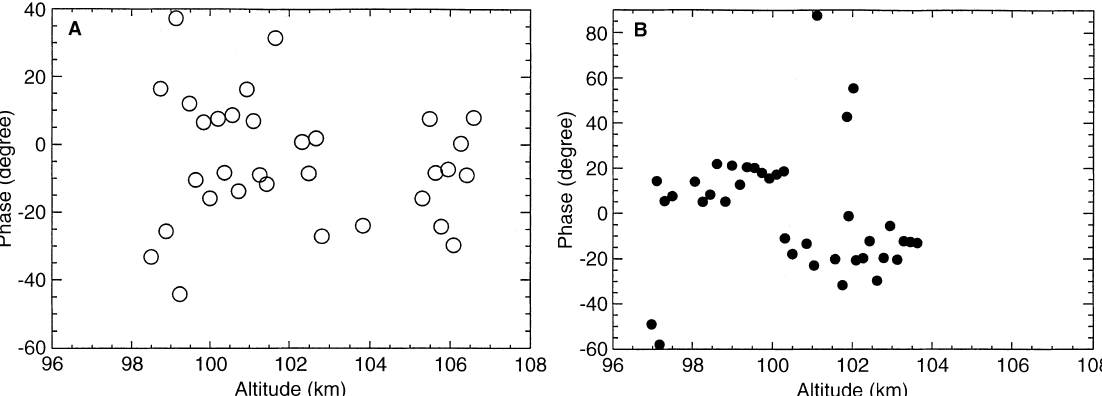
Fig. 11A, B. Relative variation in the spin/coning phase of the rocket at times where the U 1 and U 2 probe pairs are aligned to give maximum time-delay for the cross-correlation. The phases are shown